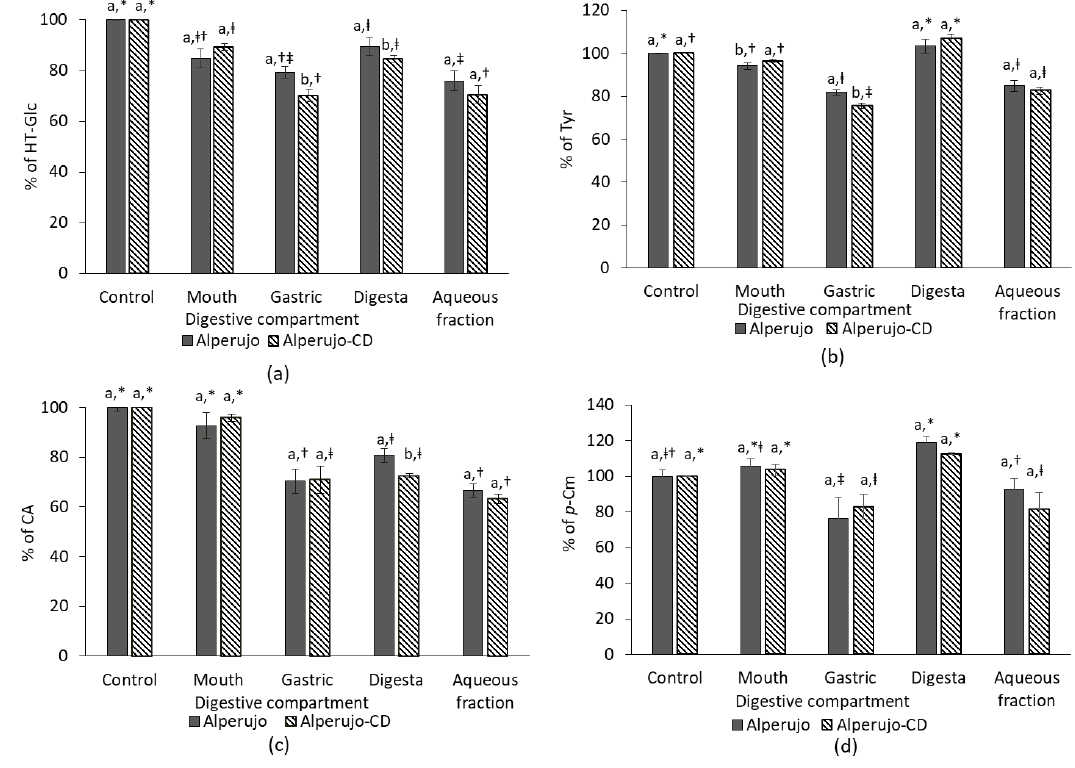
Figure 2. Bioaccessibility of phenolic compounds from alperujo powders in each digestive compartment. ( a ) HT-Glc; ( b ) tyrosol (Tyr); ( c ) caffeic acid (CA); and, ( d ) p -coumaric acid ( p -Cm) from either pure alperujo (grey bars) of alperujo complexed with β -CD (alperujo-CD, dashed bars). Values are expressed as mean ± SD ( n = 4). Different letters indicate a significant difference according to Tukey test ( p ≤ 0.05) between alperujo and alperujo-CD conditions in each compartment. Different symbols indicate a significant difference according to Tukey test ( p ≤ 0.05) between the compartments for each condition (alperujo or alperujo-CD).